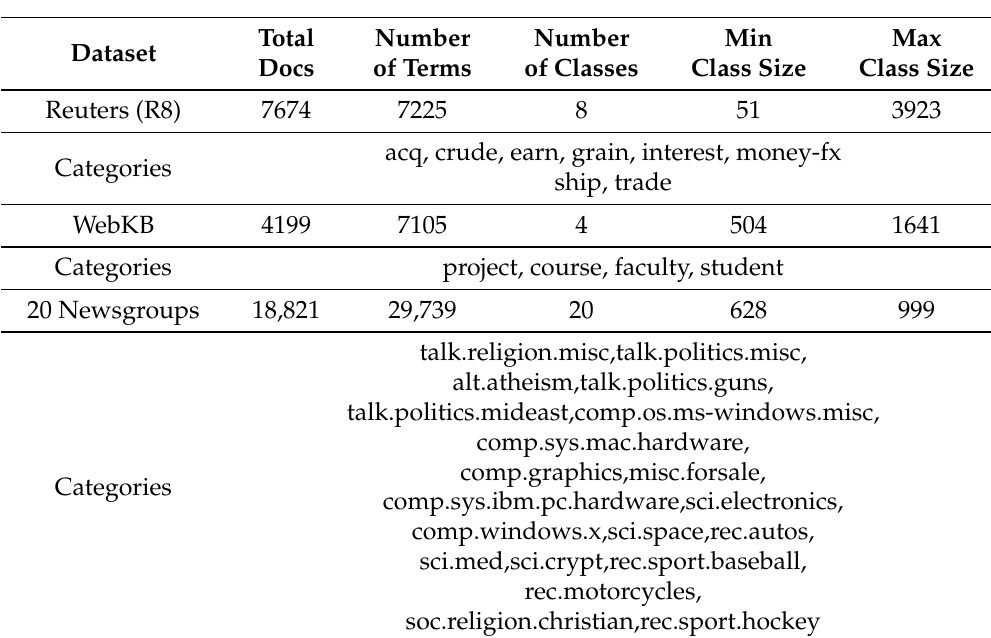
Table 5. Summary of the